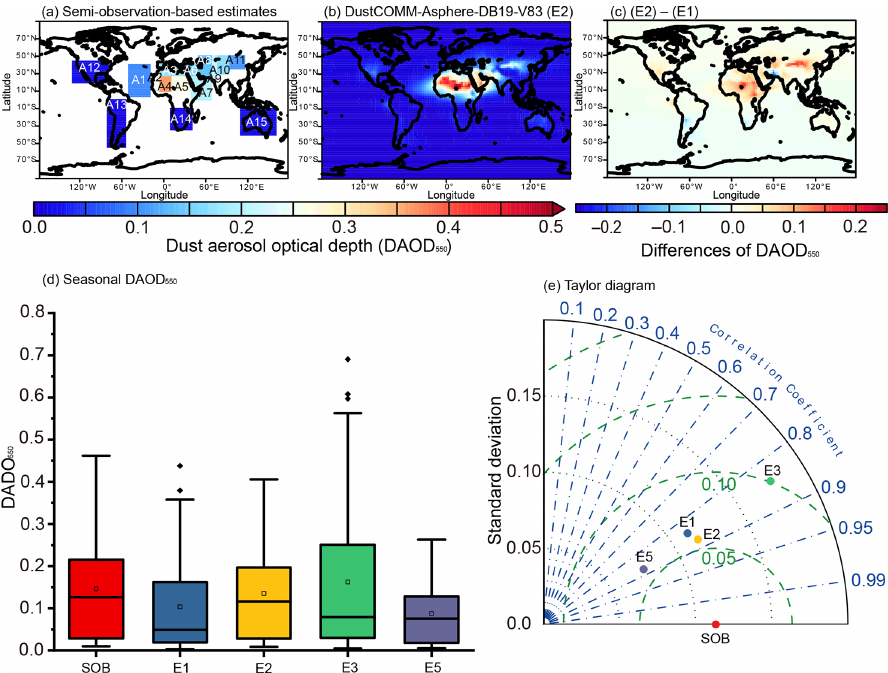
Figure 2. The model better reproduced semi-observationally based data of DAOD 550 after adjusting the size-resolved dust load with Dust- COMM and considering the dust asphericity. (a) Semi-observationally based estimates of the DAOD 550 were averaged over 2004–2008 (Ridley et al., 2016; Adebiyi et al., 2020). The annually averaged model results are shown for (b) DustCOMM-Asphere-DB19-V83 (E2) and (c) the differences between IMPACT-Sphere-Mineral-V83 (E1) and E2 simulations. (d) Comparison of seasonally averaged DAOD 550 for semi-observationally based (SOB) data, E1, E2, IMPACT-Asphere-DB19-DB17 (E3), and DustCOMM-Sphere-DB19-DB17 (E5). The square symbol represents the mean. The solid line within the box shows the median. The boundaries of the box mark the 25th and 75th per- centiles. The whiskers above and below the box indicate the 1.5 × interquartile range, and the points indicate the outliers. (e) Taylor diagram summarizing the statistics of the comparison against the seasonally averaged regional DAOD 550 for the different experiments. The horizon- tal axis shows the standard deviation of the data set or model prediction, the curved axis shows the correlation, and the green dashed lines denote the root-mean-squared errors between the semi-observationally based data and the model predictions. As such, the distance between the semi-observationally based data and the model predictions is a measure of the model’s ability to reproduce the spatiotemporal variability in the semi-observationally based data. The coordinates and the values of DAOD 550 at the 15 regions (marked in Fig. 3a) in summer are listed in Table S1. The comparison for other seasons was presented in Table